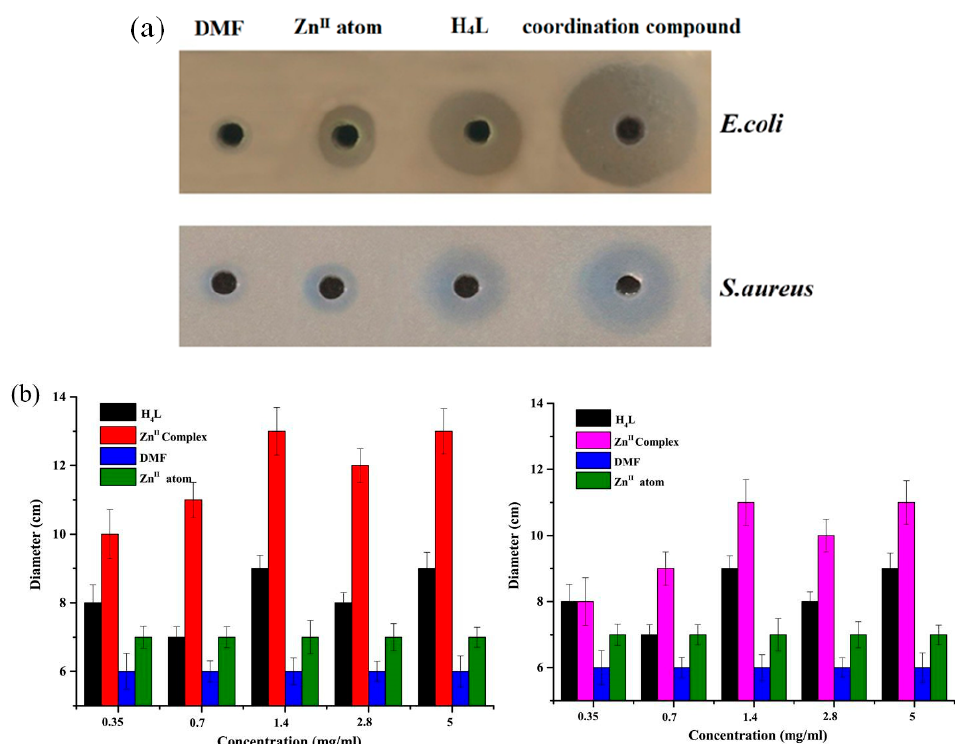
Figure 9. ( a ) The diameters of inhibition zones of E. coli and S. aureus at different concentrations; ( b ) the diameter of inhibition zones of E. coli and S. aureus in different